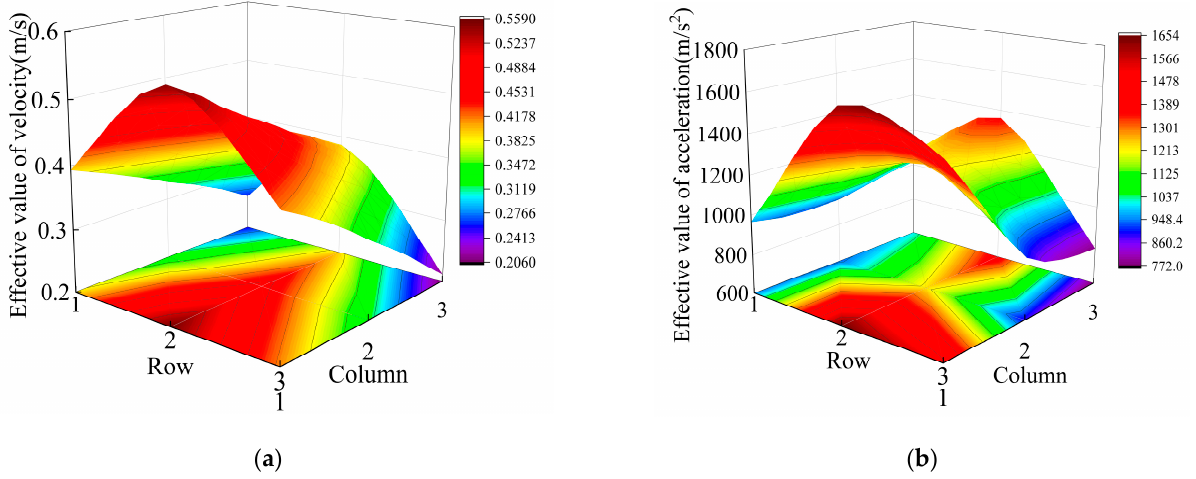
Figure 9. Vibration signal distribution in different areas on the tail beam. ( a ) Velocity. ( b ) Accelera- tion.